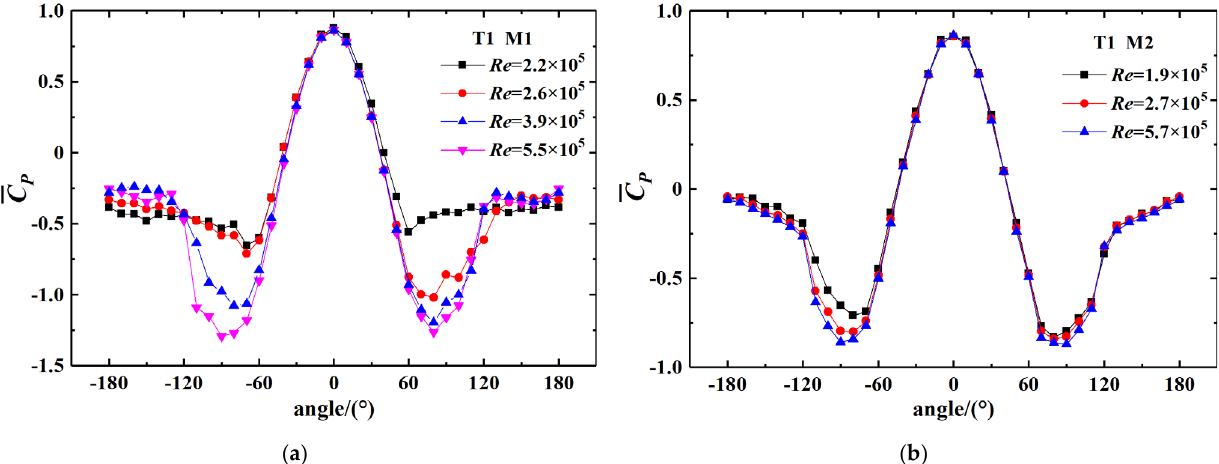
Figure 5. The distribution of the wind pressure coefficient at 0.5H of models under different Re. ( a ) M1; ( b ) M2.